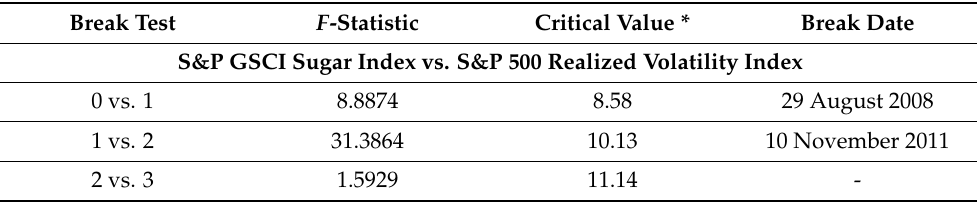
Table 4. Bai–Perron sequential test results for the S&P GSCI Sugar Index and the S&P 500 Realized Volatility Index.